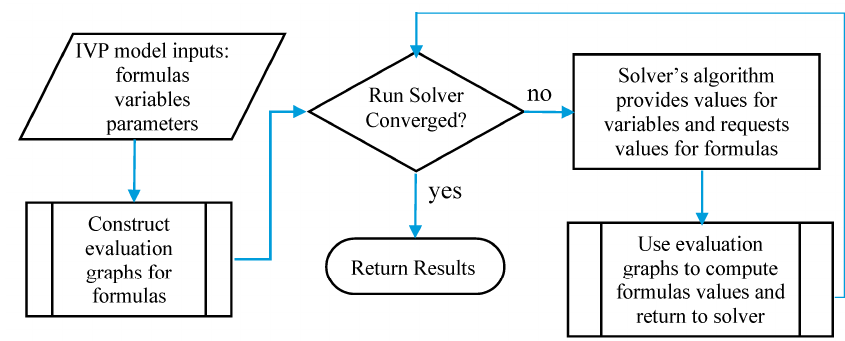
Figure 1. Flowchart for the design of a mathematically pure spreadsheet solver function which accepts formulas as input arguments. Enabling technology is described in [8,9].